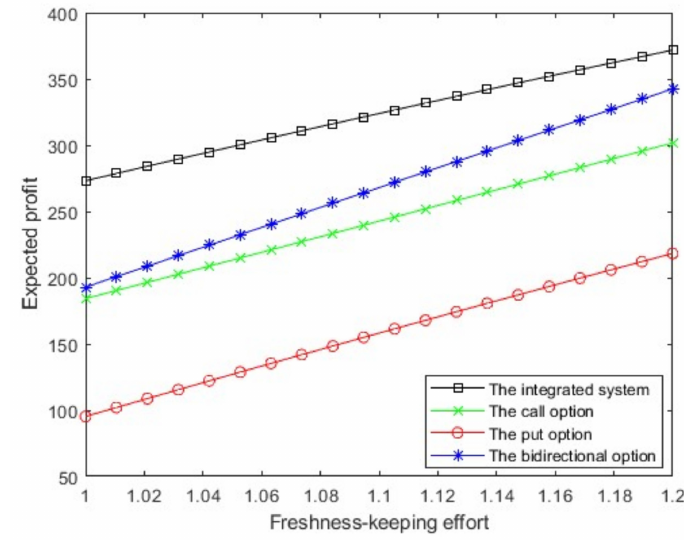
Figure 1. Expected